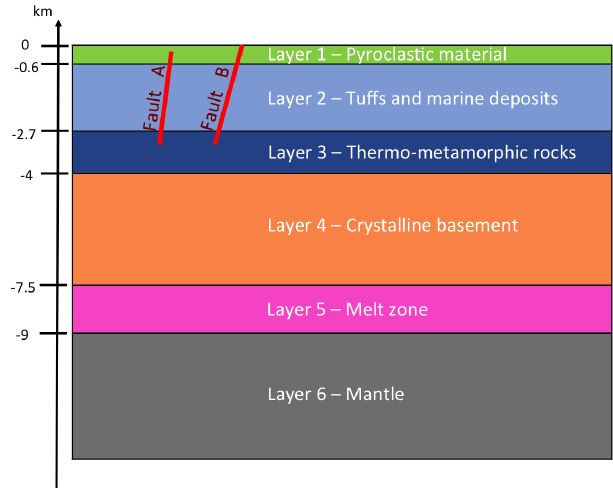
Figure 3. Heterogeneous mechanical domain. Mechanical param- eters are reported in Table 1. Inclination and radial placement of faults are not in scale. The domain extends toward infinity in the ra- dial and vertical (downward) directions. Free-stress boundary con- ditions are ascribed at the top boundary, while vanishing displace- ments are assigned at infinite